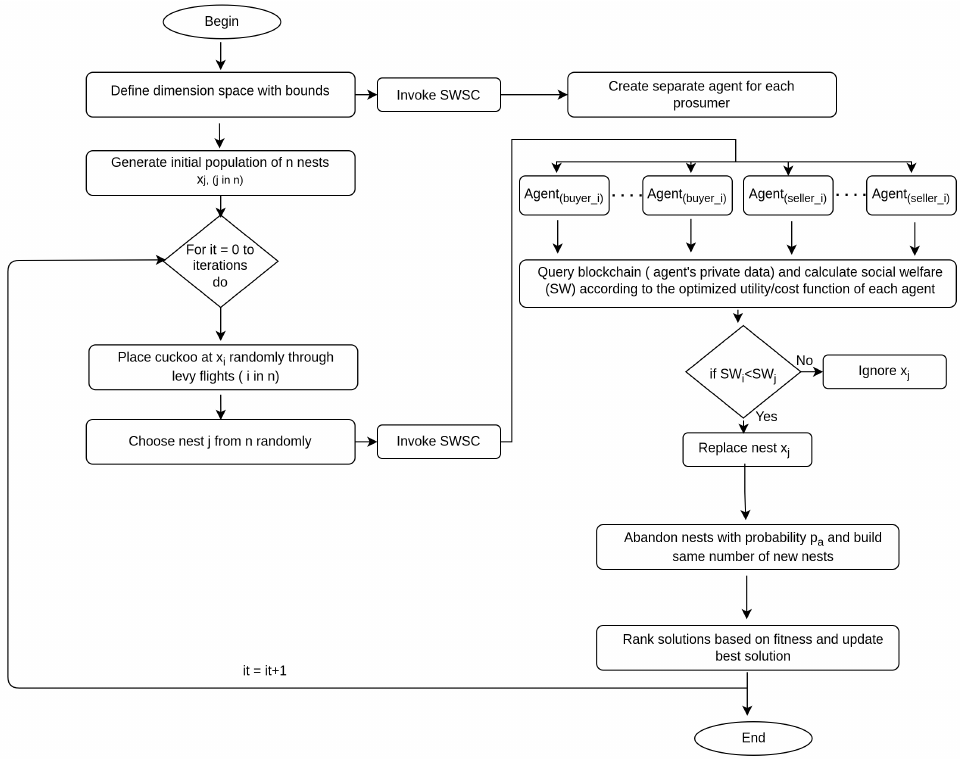
Figure 2. Modified Cuckoo search